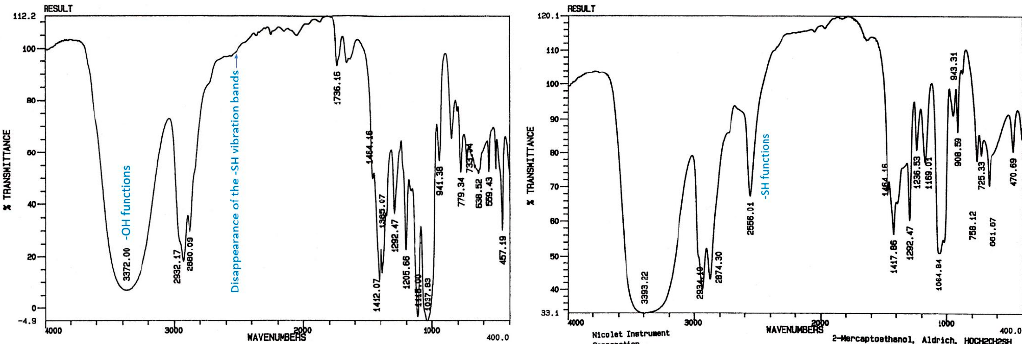
Figure 2. FTIR spectra of the total product mixture from the radical telomerisation of VDF with 2-mercaptoethanol ( left ) and of the 2-mercaptoethanol ( right ).